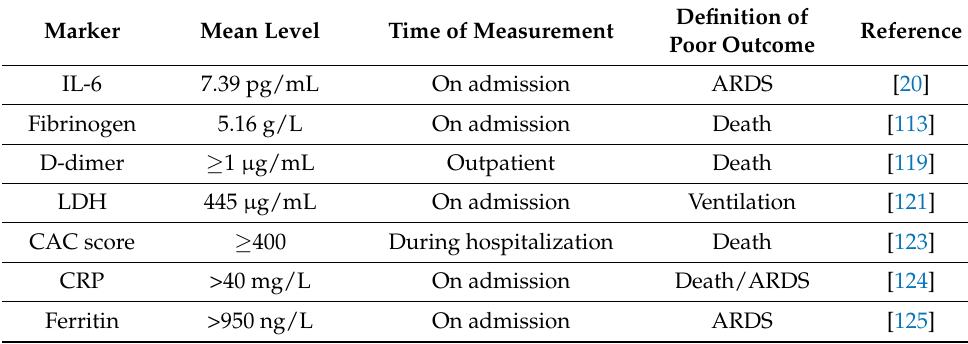
Table 2. Early Markers Associated with Poor Outcomes in COVID-19